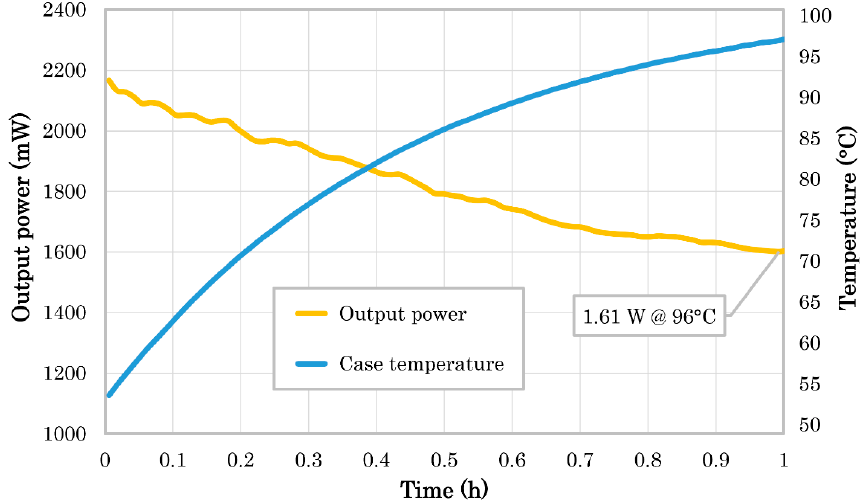
Figure 8. EDFA’s long-duration high-temperature vacuum test.